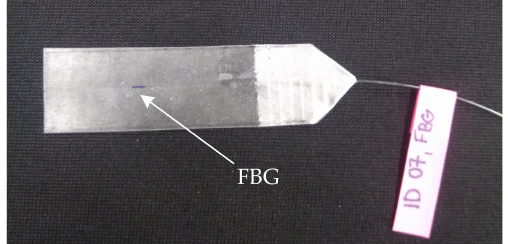
Figure 3. A prototype of created and designed measuring sensor.